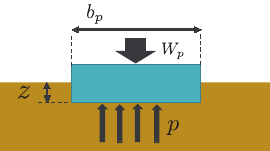
Figure 4. The relationship between a plate and soil.